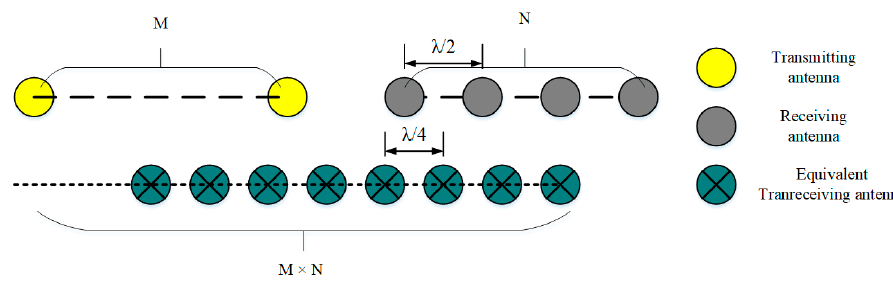
Figure 2. Antenna array layout of the MIMO radar.